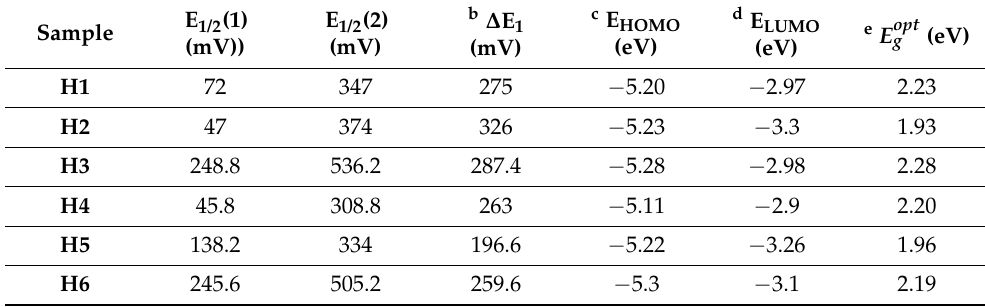
Table 2. Electrochemical properties and corresponding energy levels a .